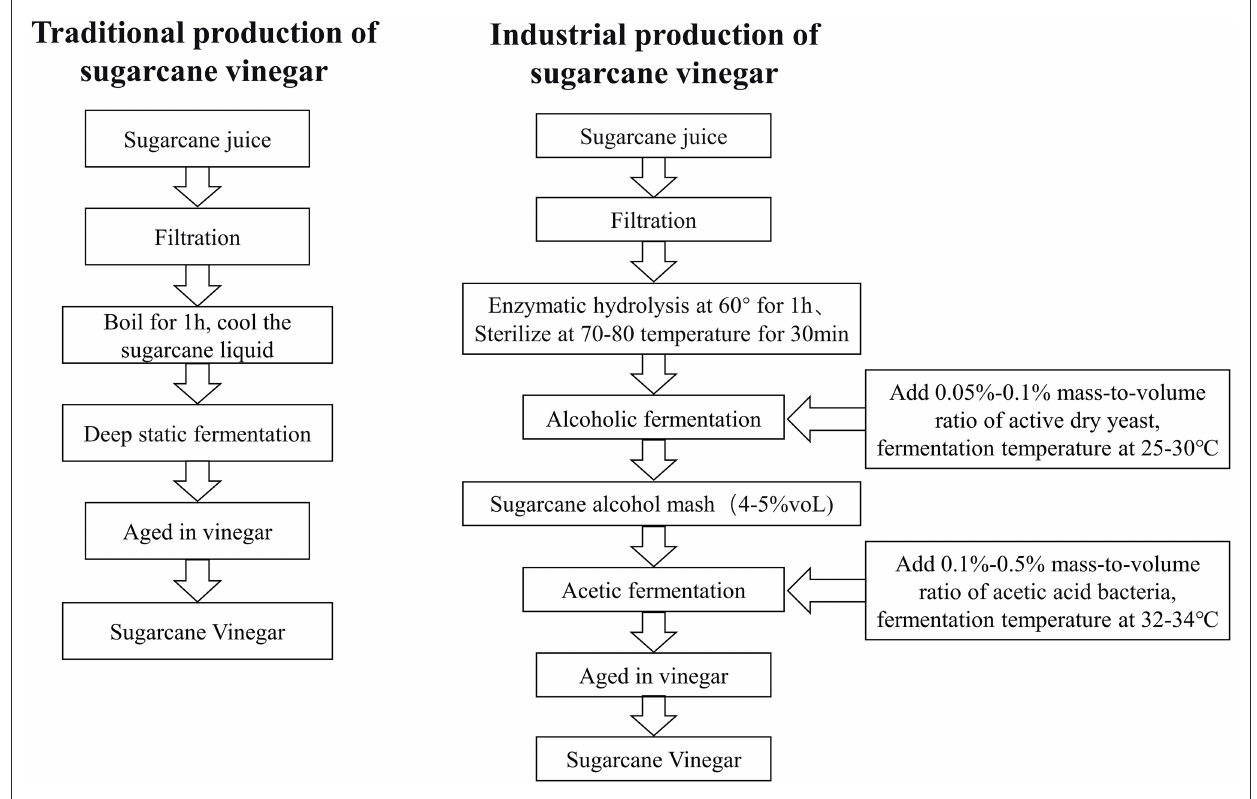
FIGURE1 Simplified production flow diagram of sugarcane